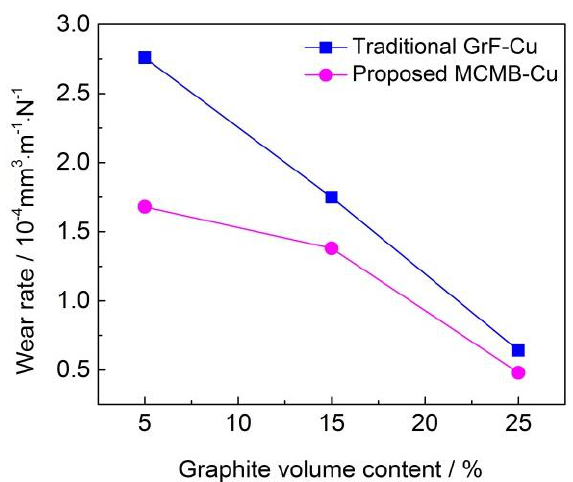
Figure 10. Wear rates of the MCMB–Cu and GrF–Cu composites under different MCMB and GrF volume contents.